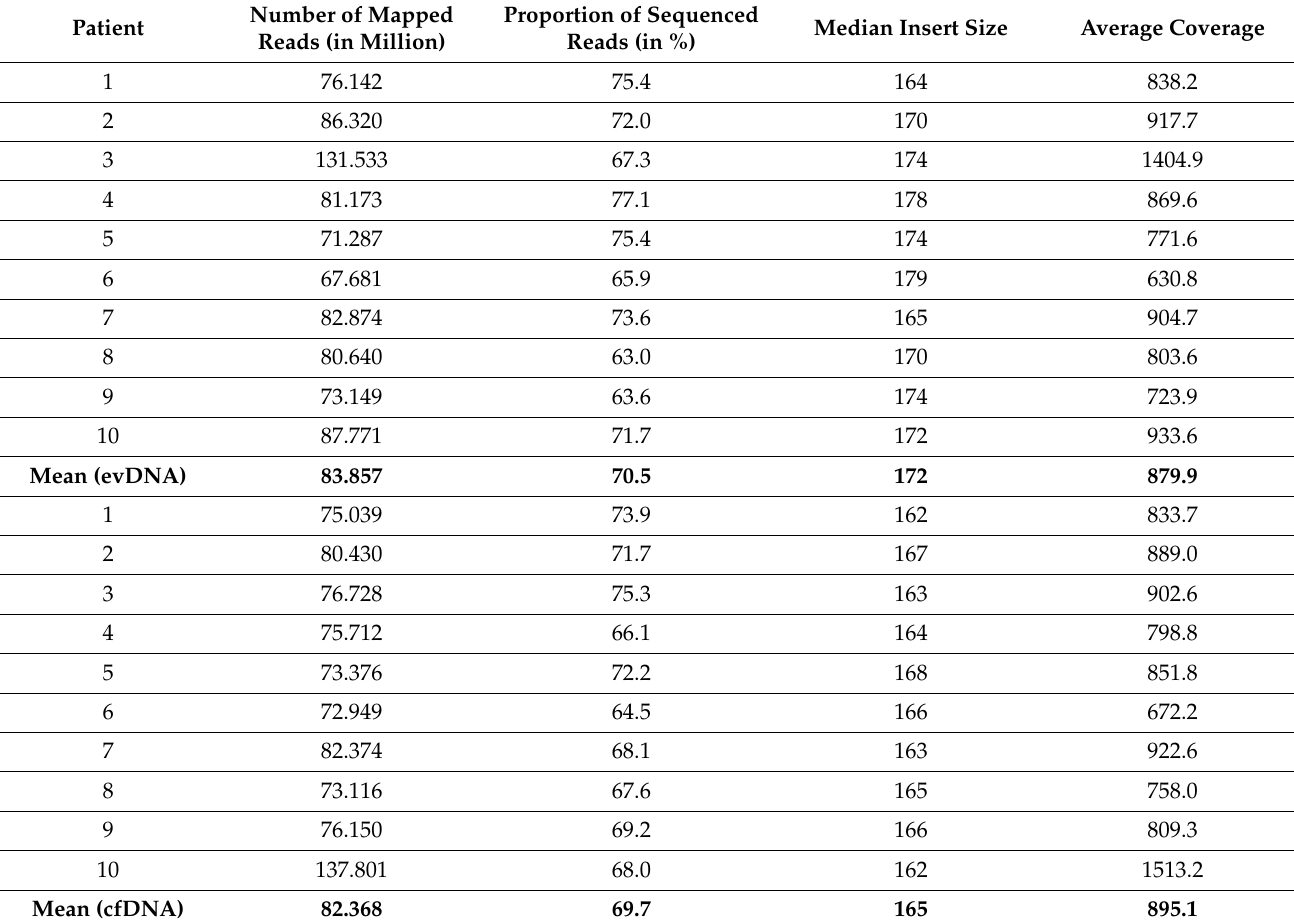
Table 3. Quality parameters of sequencing data for ev- and